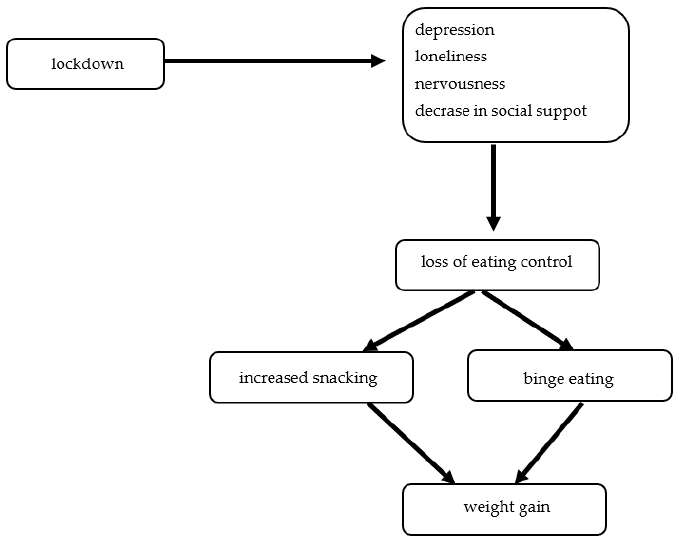
Figure 5. The risk factors of weight gain during the COVID-19 pandemic lockdown among patients with obesity after bariatric surgery.